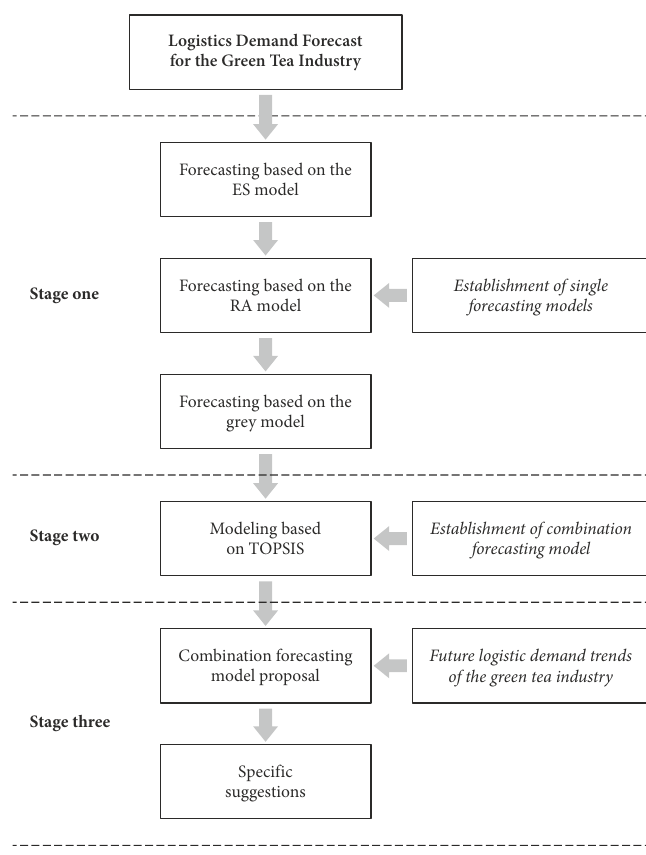
Figure 1. Research